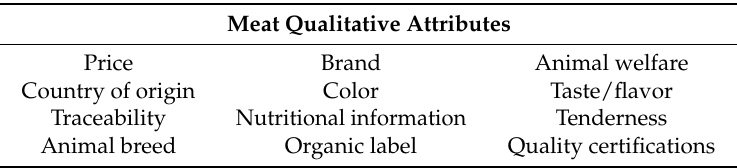
Table 1. Meat quality attributes used for the Best-Worst